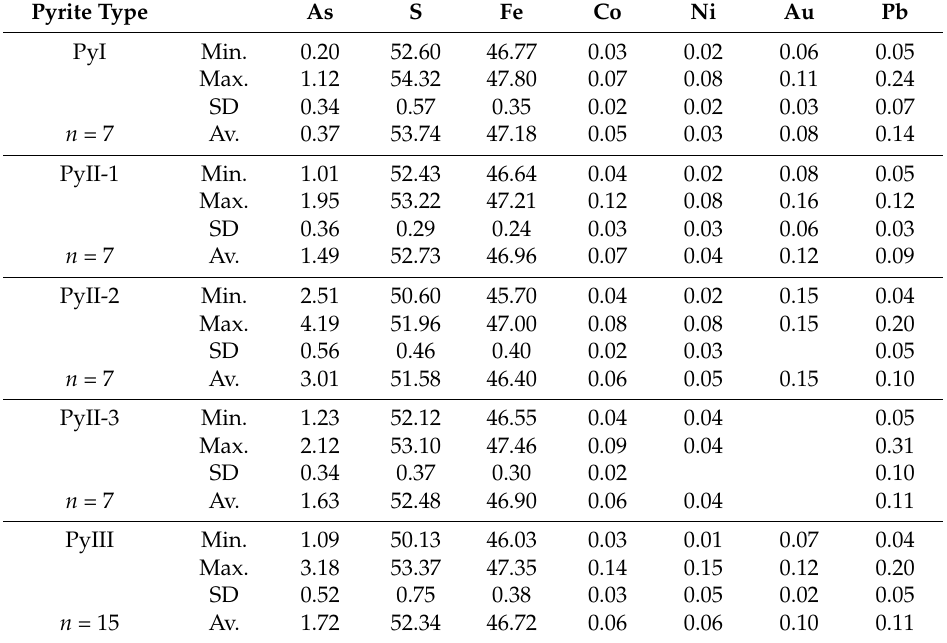
Table 2. Selected EPMA analyses of different generations of pyrite from the Zhengchong deposit (wt %). Pyrite Type As S Fe Co